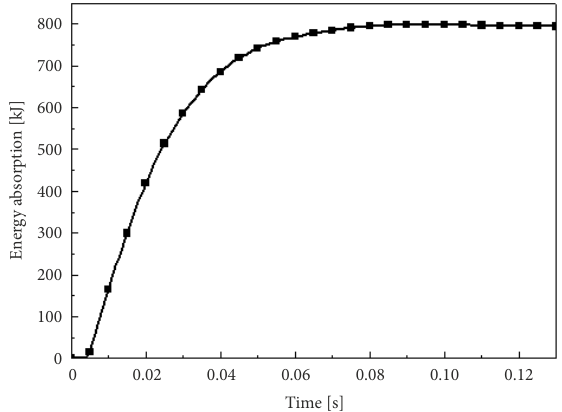
Figure 5. Energy absorption characteristic curve of the vehicle